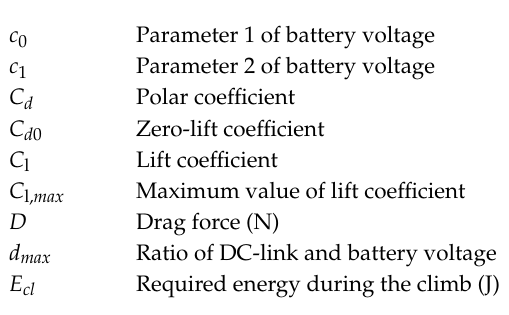
Figure 13. Real-time simulation of the case 11 Ah, n p = 21, n s = 29, 540 V on the DC-link: SoC (blue line) and output voltage (green line).